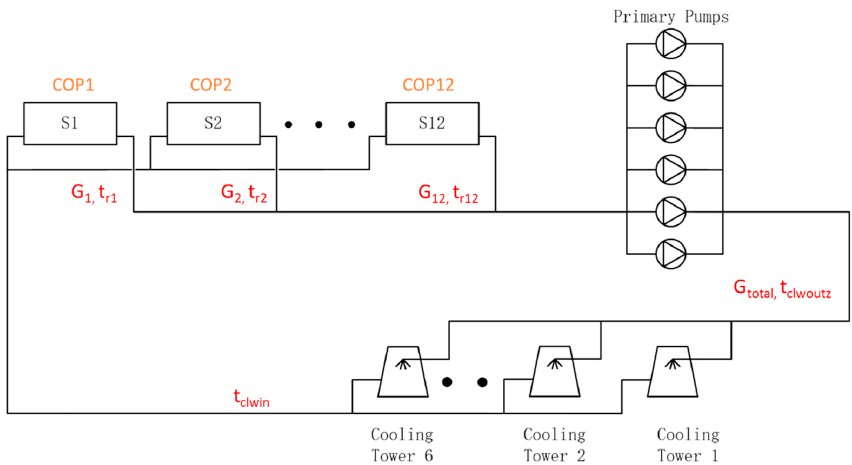
Figure 1. Schematic diagram of the current conventional central circulating pump (CCCP) system.